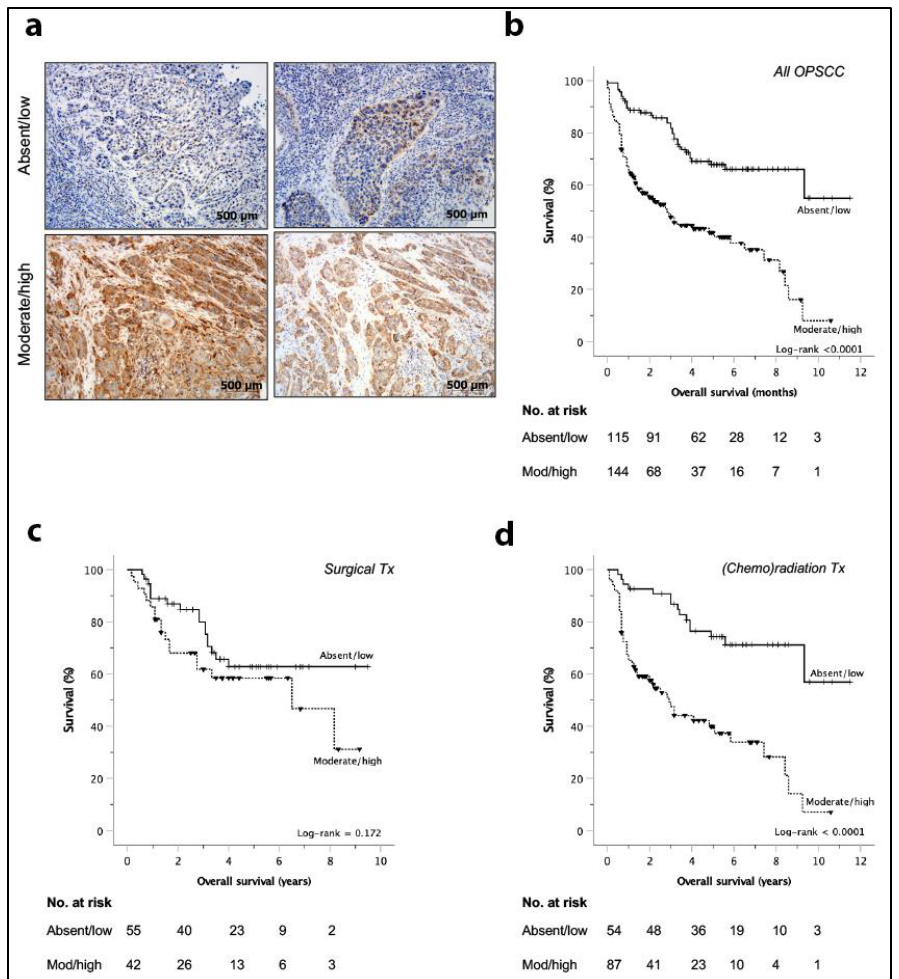
Figure 5. Survivalanalysisfororopharyngealsquamouscellcarcinoma(OPSCC)dataset. ( a )Representative Figure 5. Survival analysis for oropharyngeal squamous cell carcinoma (OPSCC) dataset. ( a ) Representative immunohistochemistry slides showing examples of CTEN expression levels in HPV −ve immunohistochemistryslidesshowingexamplesofCTENexpressionlevelsinHPV − ve andHPV + ve HNSCC. Scale bar = 500 microns. ( b – d ) Kaplan–Meier overall survival curves for all oropharyngeal SCC ( n = 259) with CTEN expression scored on immunohistochemistry as low (absent / weak) or high (moderate / high): ( b ) demonstrating a significant correlation between CTEN expression and overall survival in OPSCC (log-rank < 0.0001). Analysis by primary treatment modality demonstrated that the surgery group ( c ) failed to show an association with CTEN expression (log-rank = 0.172) whereas the cohort undergoing organ sparing treatment modalities ( d ) (chemo) radiation) again showed a significant correlation between CTEN expression and overall survival (log-rank <